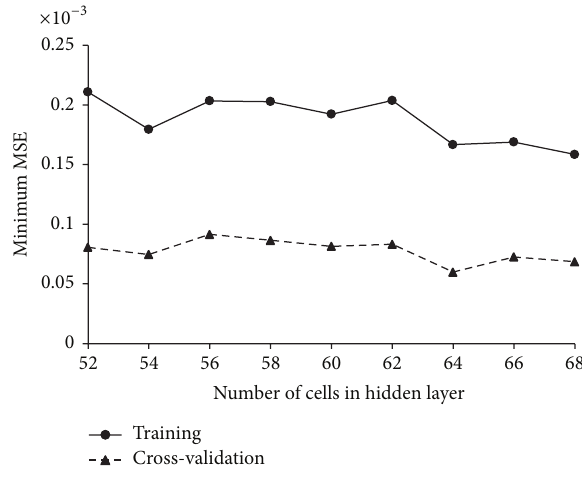
Figure 3: Training and cross-validation curves attributed with MSE for